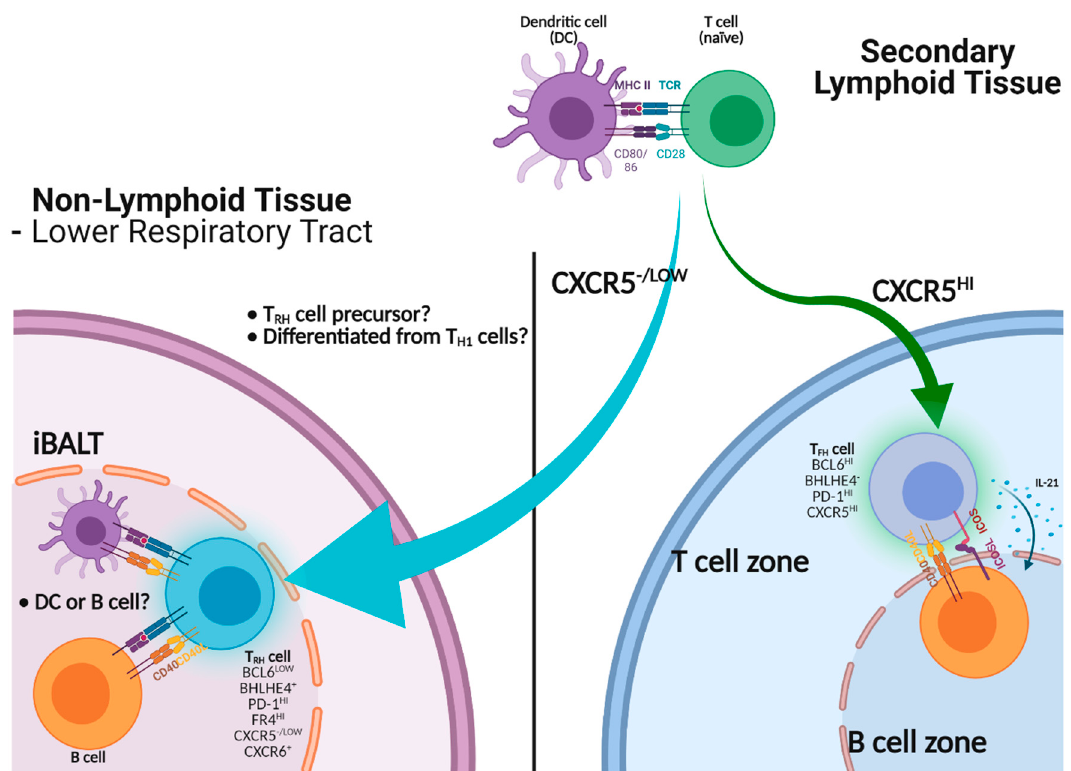
Figure 1. Help of B cell immunity by T RH or T FH cells. Activated CD4 T cells migrate into the B cell zone to become mature CXCR5 hi T FH cells to help B cells via CD40-CD40L, ICOS-ICOS-L interactions and cytokines including IL-21. T RH precursors, which express low levels of CXCR5, can infiltrate into non-lymphoid tissues such as the lung. T RH precursors adapt to the lung environment to become mature T RH cells, thereby assisting B cell immunity in situ through the expression of